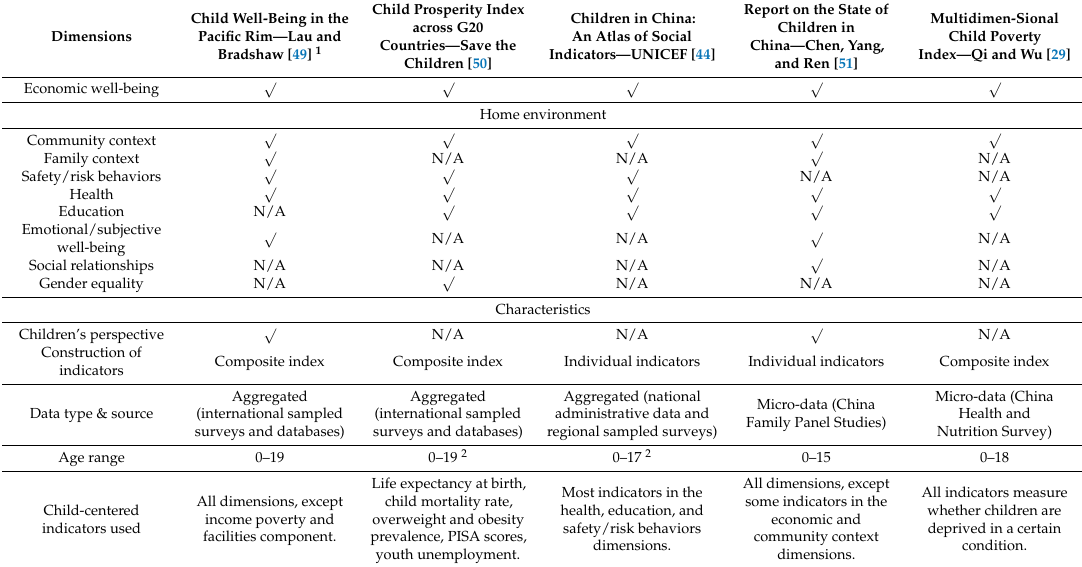
Table 1. Dimensions and characteristics used in child well-being measurements for